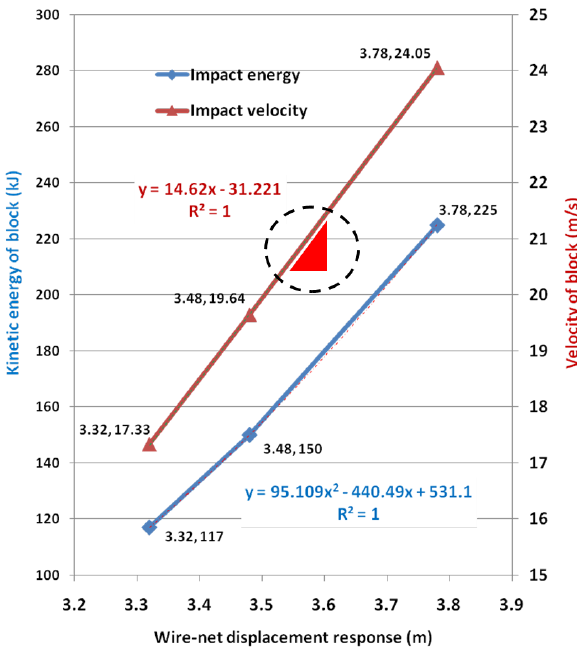
Figure 12. Displacement response of R-LPR at various incident velocities and the 2 Fig. 12. Displacement response of R-LPR at various incident ve- corresponding kinetic energies of the impacting block by using the model shown in Fig. (10). 3 locities and the corresponding kinetic energies of the impacting The slope to be determined is marked by a circle. 4 block by using the model shown in Fig. 10. The slope to be de- termined is marked by a